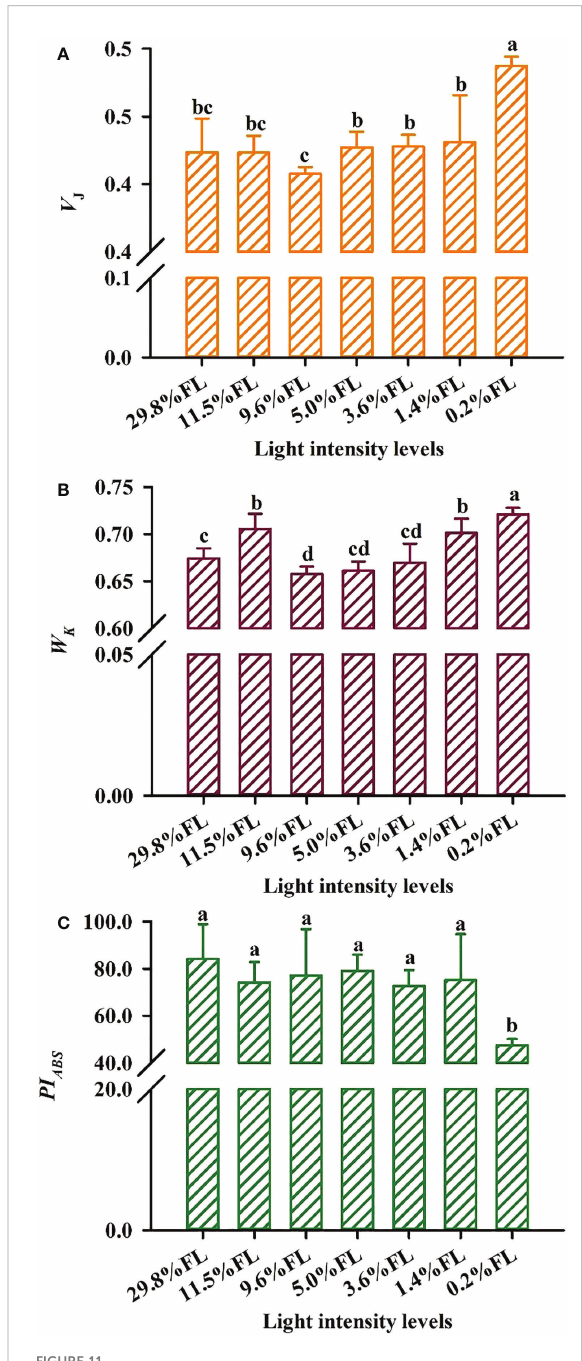
FIGURE 11 Effect of light regimes on the V J , W k and PI ABS of P. notoginseng leaves. (A) V J is the relative variable fl uorescence intensity at the J-step; (B) W k is the K phase in O-J-I-P chlorophyll fl uorescence induction curves. (C) PI ABS is the performance index on absorption basis. Values for each point were means ± SD ( n = 7). Letters indicate signi fi cant differences at P < 0.05 according to Duncan ’ s multiple range